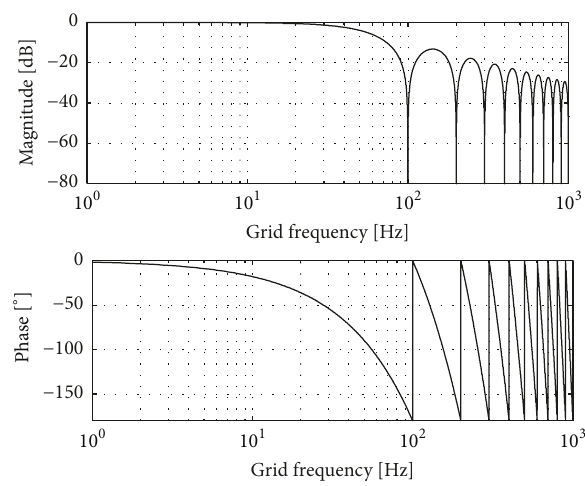
Figure 3: MAF Bode plots obtained with T